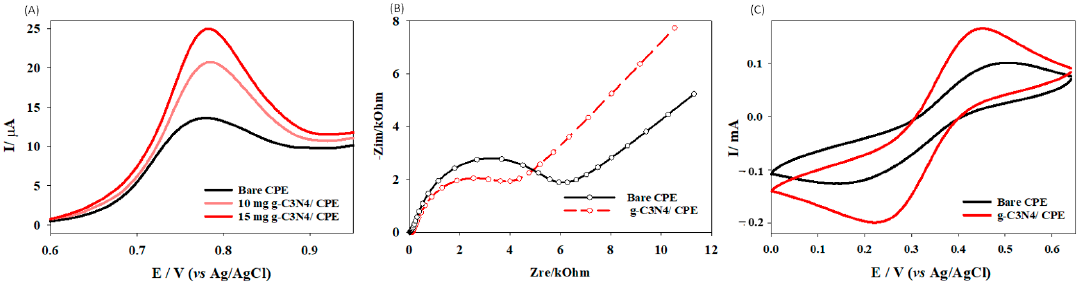
Figure 5. ( A ) Square-wave Voltammetry (SWV) of 1 × 10 − 4 M of MTX using bare carbon paste electrode (CPE), 10 mg and 15 mg of g-CN in pH 7.0 Britton–Robinson buffer (BRB), and ( B , C ) Electrochemical impedance spectroscopy (EIS) and Cyclic Voltammetry (CV) of bare CPE and g-CN in 5.0 × 10 − 3 M K 3 Fe(CN) 6 in 0.1 M KCl, respectively, utilizing bare CPE and g-CN. A 1:1 solution of 5.0 × 10 − 3 M K 3 Fe(CN) 6 in 0.1 M KCl was utilized to examine the